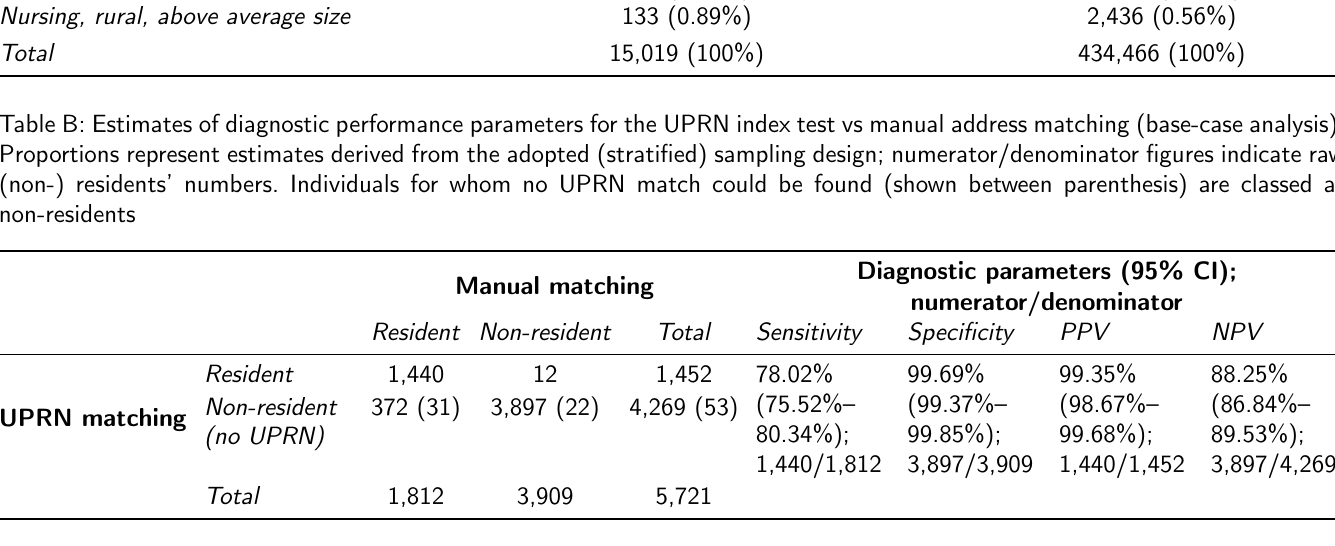
Table C: Estimates of diagnostic performance parameters for the UPRN index test vs manual address matching (sensitivity analysis). Proportions represent estimates derived from the adopted (stratified) sampling design; numerator / denominator figures indicate raw (non-) residents’ numbers. Individuals for whom no UPRN match could be found (shown between parenthesis) are classed